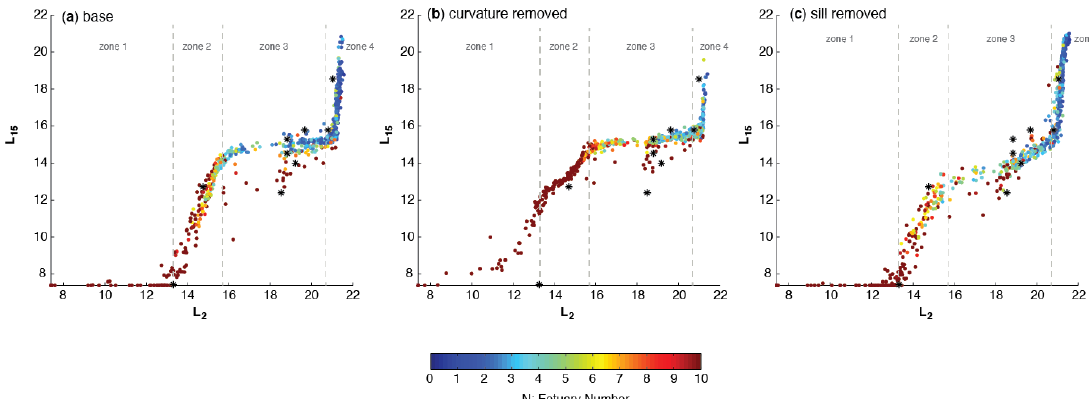
Fig. 8. Length of estuary where the depth-averaged salinity = 15psu ( L 15 ) against limit of salinity intrusion ( L 2 ) over the range of river to tidal ratios; * represent interpolated field data. Vertical black lines refer to the position of the three points of inflection. (a) Using the original mesh; (b) using a straightened mesh, sill included; and (c) using the original mesh with sill removed.